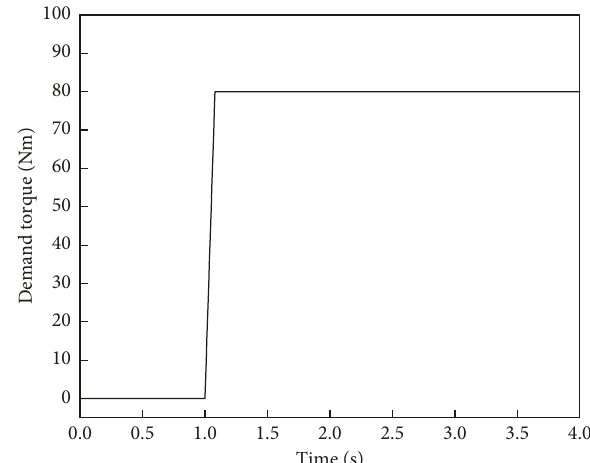
Figure 3: Demand torque change in the tip-in process.